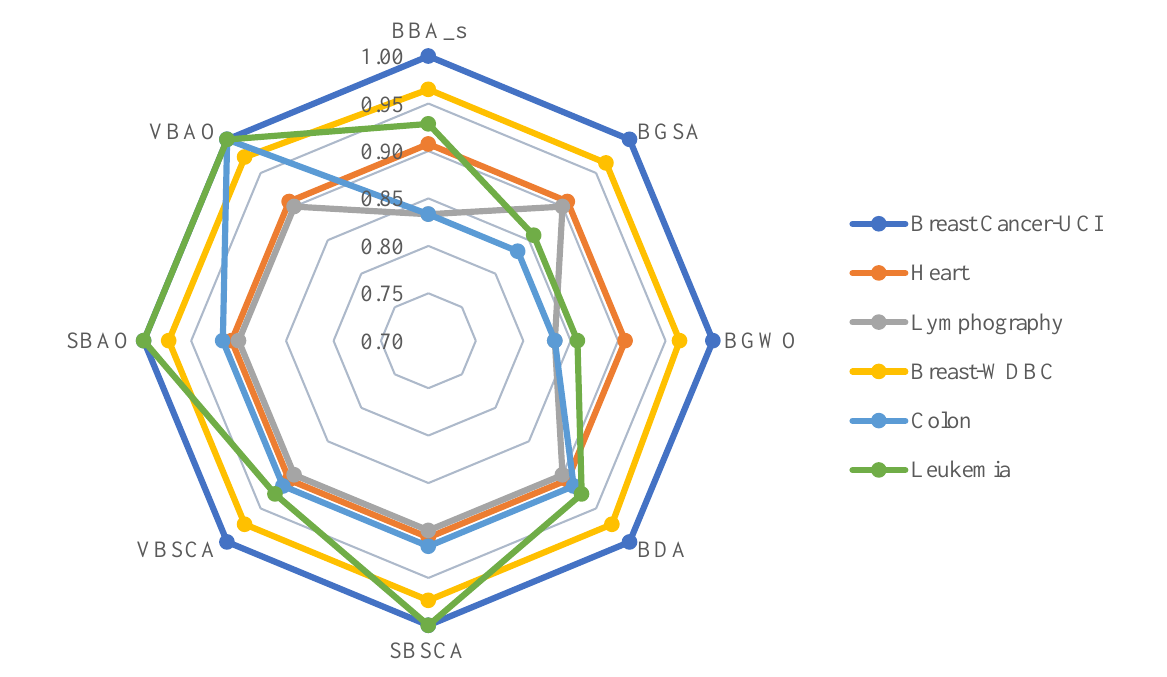
Figure 2. Average accuracy gained by BAO and comparative algorithms. Table 8. The number of selected features comparison of SBAO and VBAO with comparative algo- rithms.